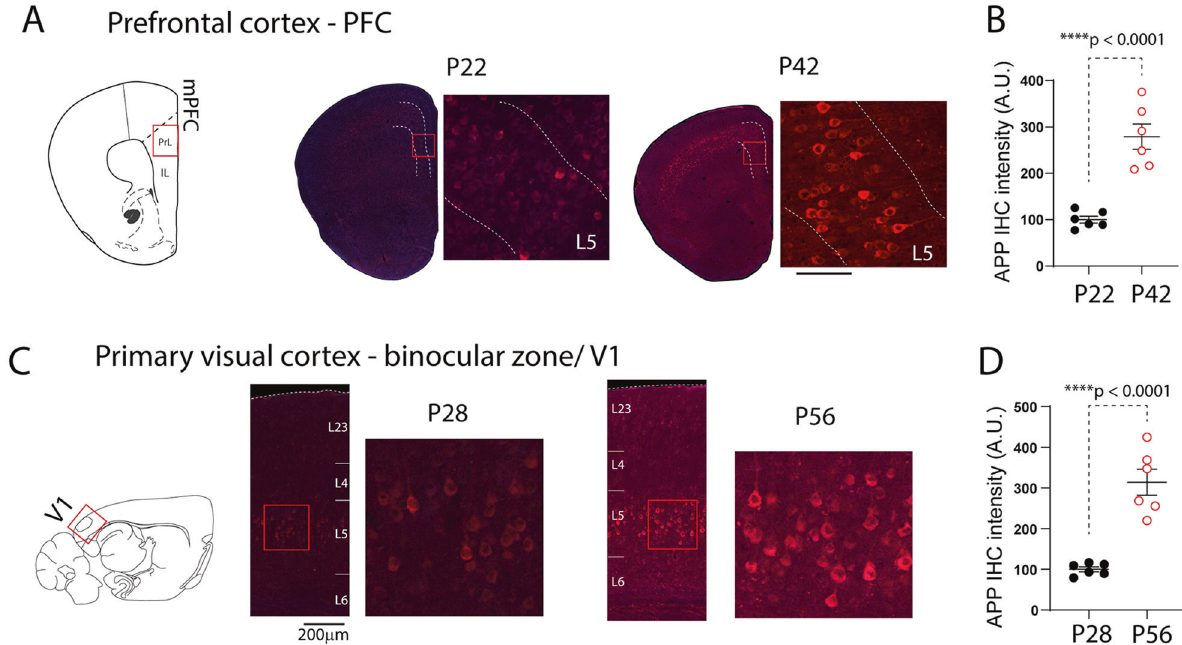
Fig. 1 Age-dependent transgenic APP/A β overloading in L5 neurons in PFC and VC. A Immunohistochemistry staining for APP/A β using the 6E10 antibody. L5 neurons show immunoreactivity of APP/A β in prefrontal cortex at P22, with much stronger labeling at P42. B Intraneuronal APP/A β immunoreactivity was signi fi cantly stronger in P42 compared to that from P22 (t 10 = 6.35, n = 6 mice/group, **** p < 0.0001). C APP/A β immunolabeling in L5 pyramidal neurons in the primary visual cortex (V1) at P28 and P56. D Quanti fi cation of APP/A β signals show a signi fi cant increase in V1-L5 neurons at P56 (t 10 = 6.67, n = 6 mice/group, **** p <